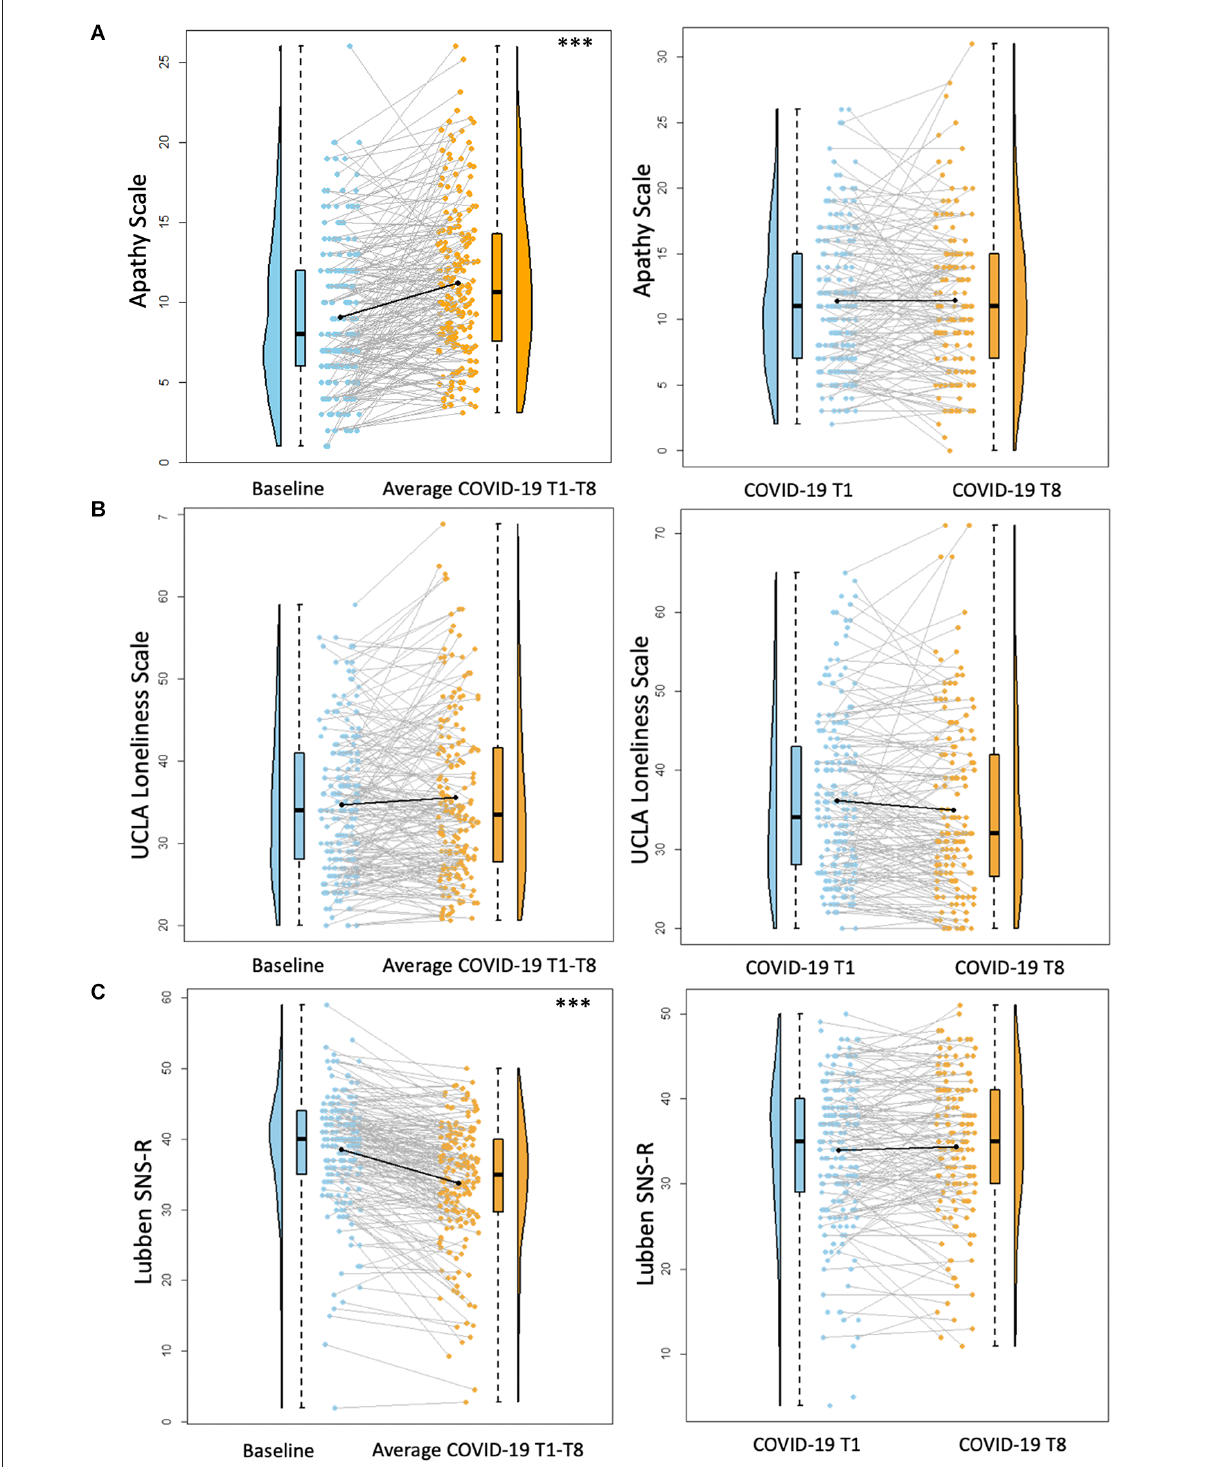
FIGURE3 Psychosocial results pt. 2. Plots depicting the raw distribution of data points collected for (A) Apathy Scale; (B) University of California Los Angeles (UCLA) Loneliness Scale; and (C) Lubben Social Network Scale—Revised (SNS-R). The plots on the left side of the panel represent change from pre-pandemic baseline to during the pandemic (average of COVID-19 timepoints 1–8), while the plots on the right side of the panel represent change throughout the pandemic (COVID-19 timepoint 1 vs. timepoint 8). ∗∗∗ p <